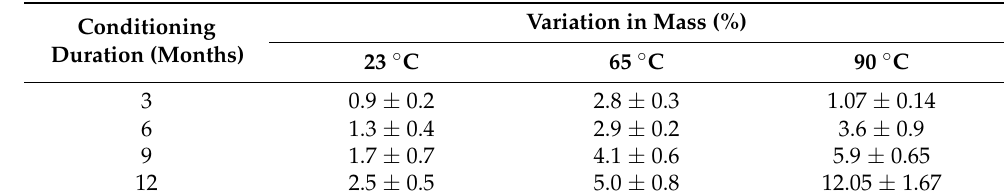
Table 2. Percentage change in mass of E-glass/epoxy specimens.